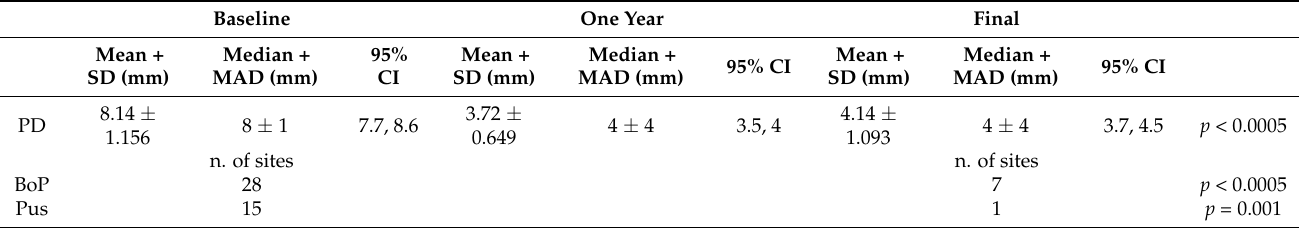
Table 2. Outcome